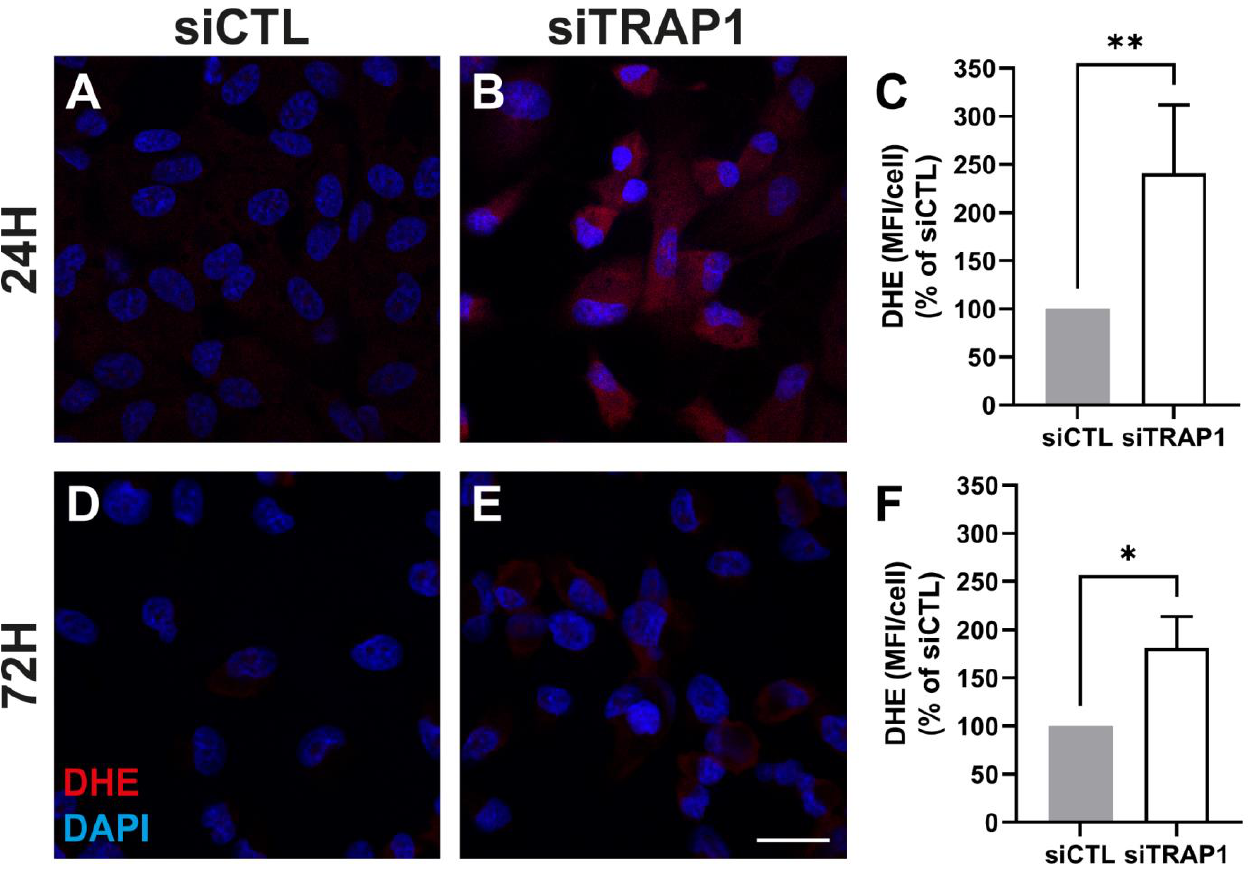
Figure 4. TRAP1 silencing in ARPE-19 cells increase the levels of superoxide anion. Representative confocal microscopy images of fluorescent detection of ROS by dihydroethidium (DHE) in cells transfected with siCTL ( A , D ) and siTRAP1 ( B , E ) for 24 h ( A , B ) and 72 h ( D , E ). Scale bars: 20 µm. Mean fluorescence intensity (MFI) of at least 4 images per condition/experiment was measured using Image J v1.53C and divided by the number of the DAPI-positive nuclei (MFI/cell) ( C , F ). Four independent experiments were performed ( n = 4). Statistical significance was calculated by using the Mann—-Whitney U test. Statistically significant values: * p < 0.05, ** p < 0.01. In the graphs, all values are expressed as mean ± standard error of the mean